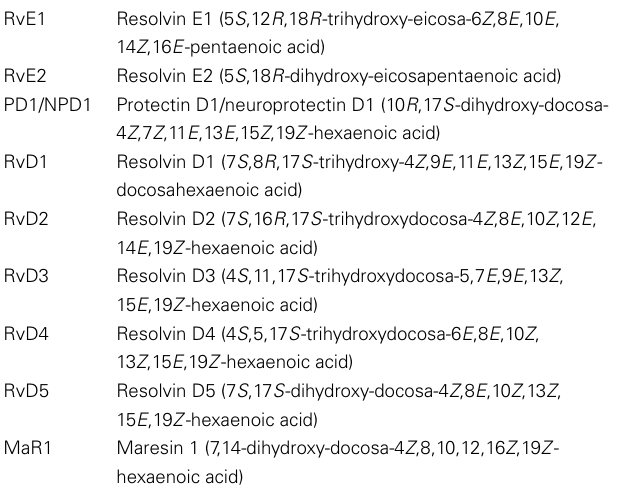
Table 1 | Key structures of the SPM: resolvins, protectins, and maresins